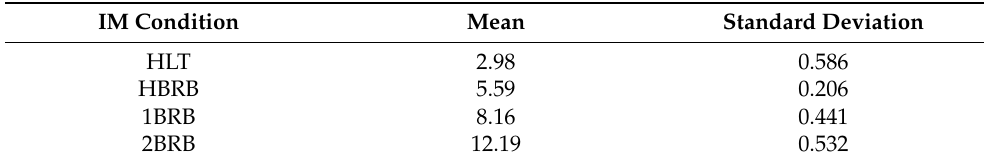
Figure 16. Energy calculated values. Table 3. Mean and standard deviation of the energy values.